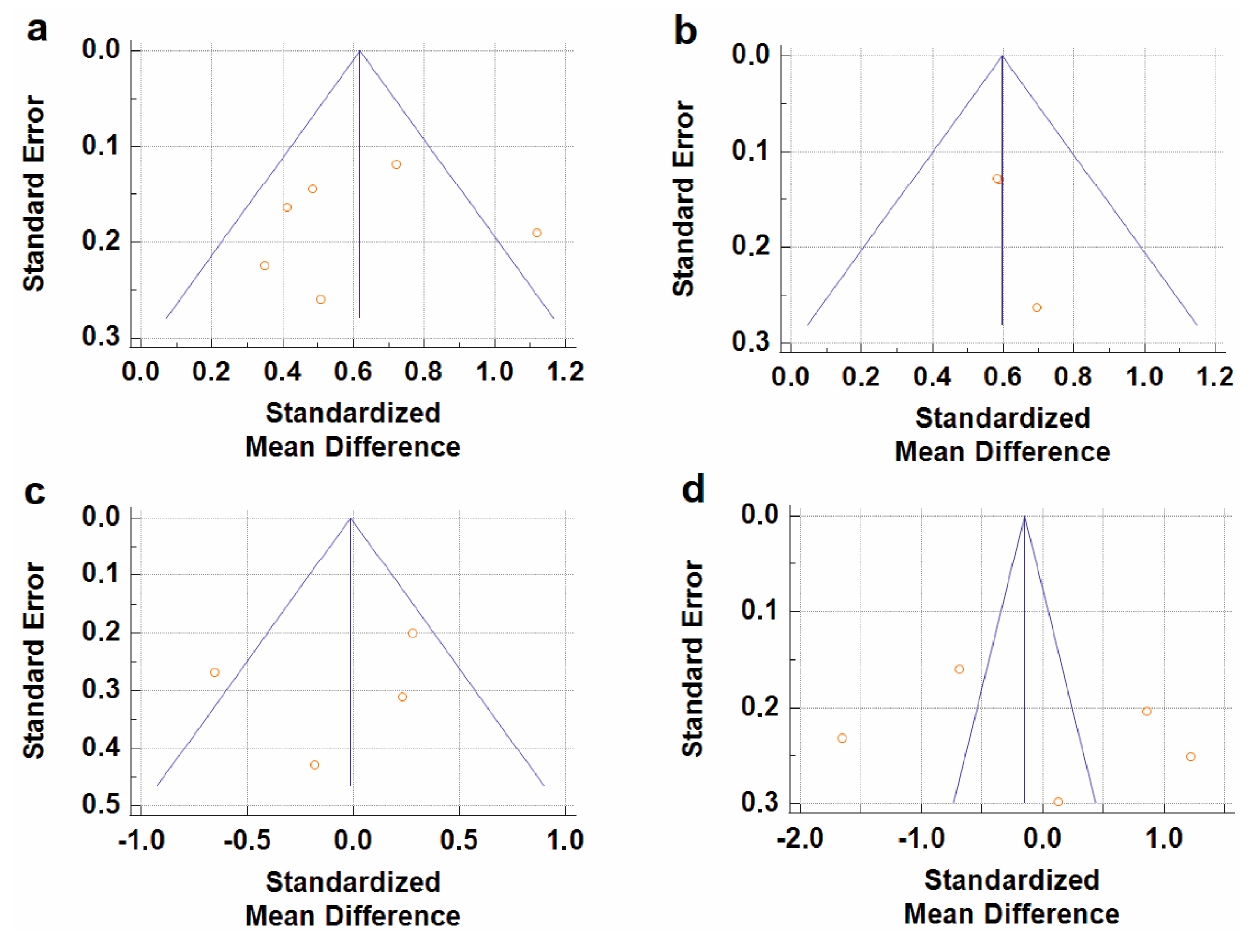
Figure 3. Funnel plots for the analysis of the level of bias in meta-analytical data for total cfDNA in schizophrenia ( a ), cf-gDNA in schizophrenia ( b ), cf-mtDNA in BD ( c ), and cf-mtDNA in DDs ( d ).